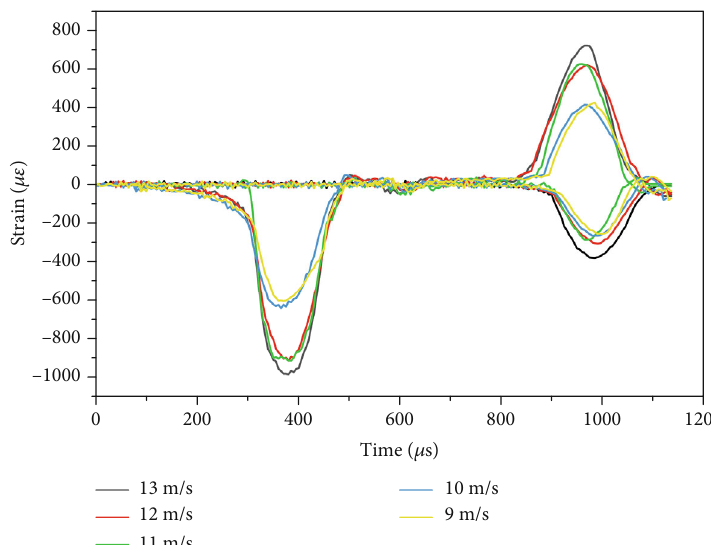
Figure 10: Some examples of incident, re fl ected, and transmitted strain signals under di ff erent loading velocities.